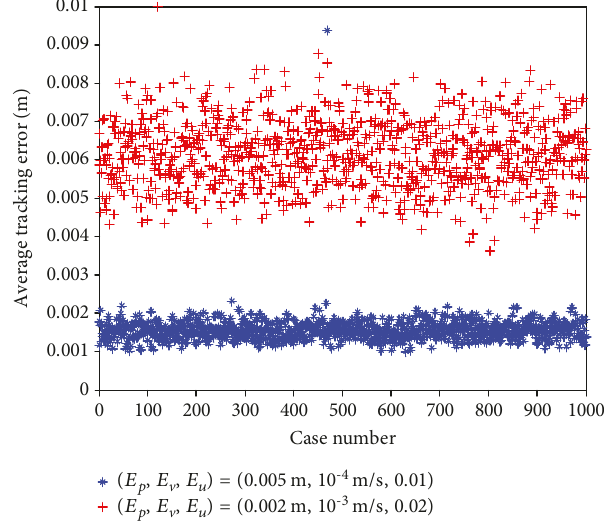
Figure 13: Performance comparison in terms of controller